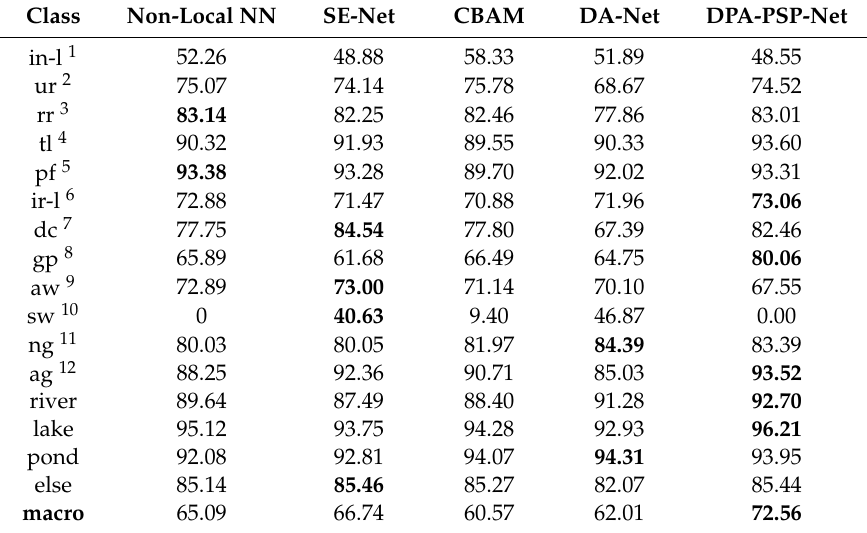
Table 8. F1-score for each category of the di ff erent self-attention models.